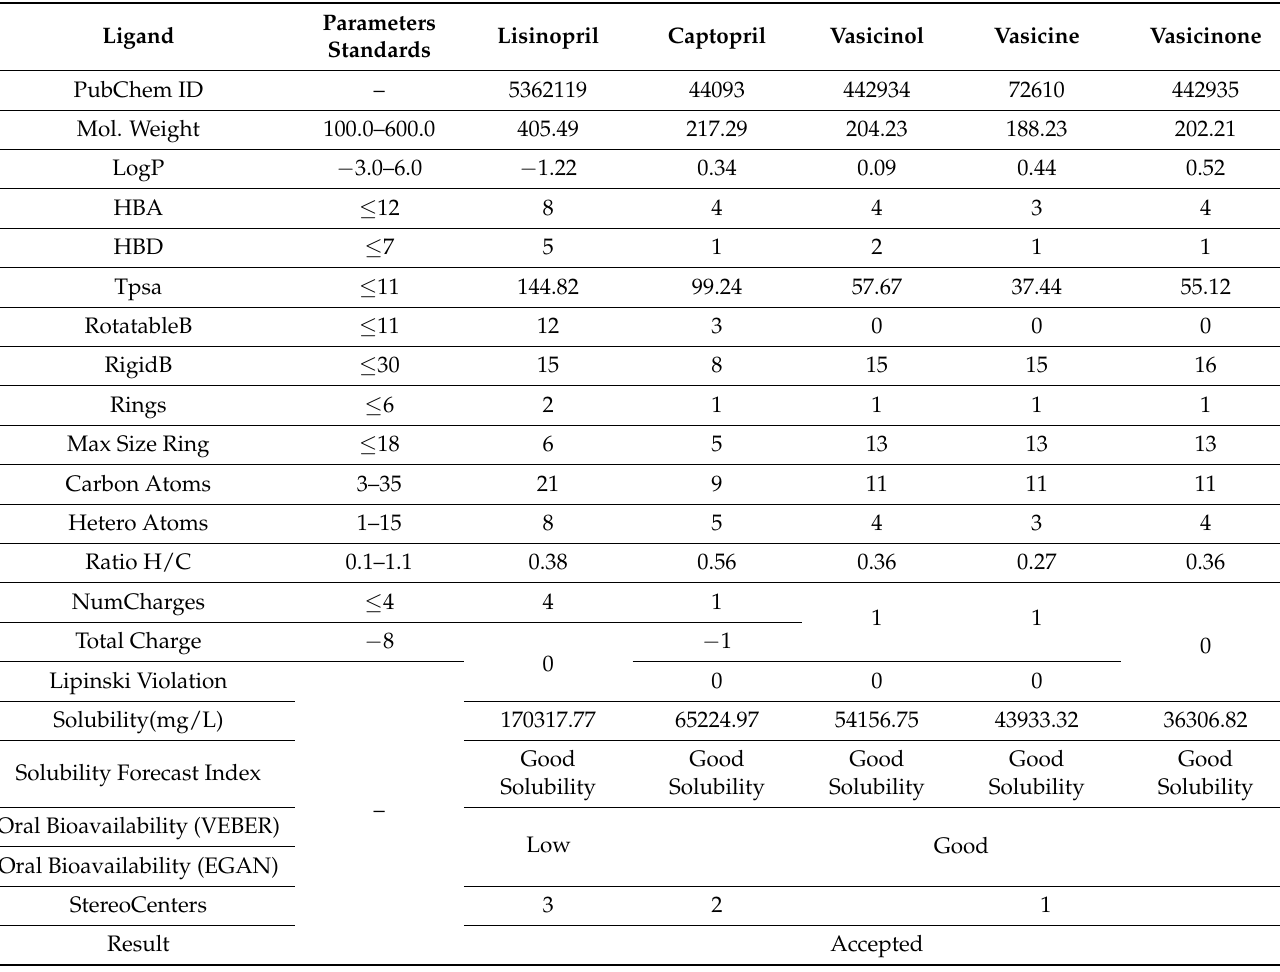
Table 4. Analysis of compounds using FAF Drugs 4 for ADME/Tox